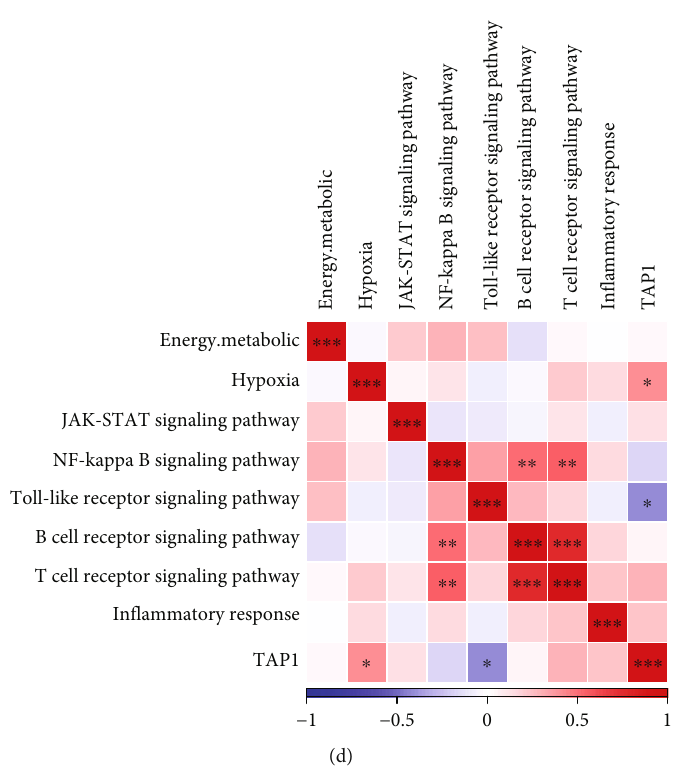
Figure 8: Pathway analysis of aberrant regulation of TAP1 gene: (a) heat map of aberrantly regulated pathway enrichment scores; (b) di ff erence in aberrantly regulated pathway enrichment scores between the high- and low-expression groups of the TAP1 gene; (c) point bar graph of correlation between aberrantly regulated pathway enrichment scores and TAP1 gene expression, where color is signi fi cance and size of point is strength of correlation; (d) correlation between TAP1 expression and hypoxia, energy metabolism, and in fl ammation-related pathways in a correlation heat